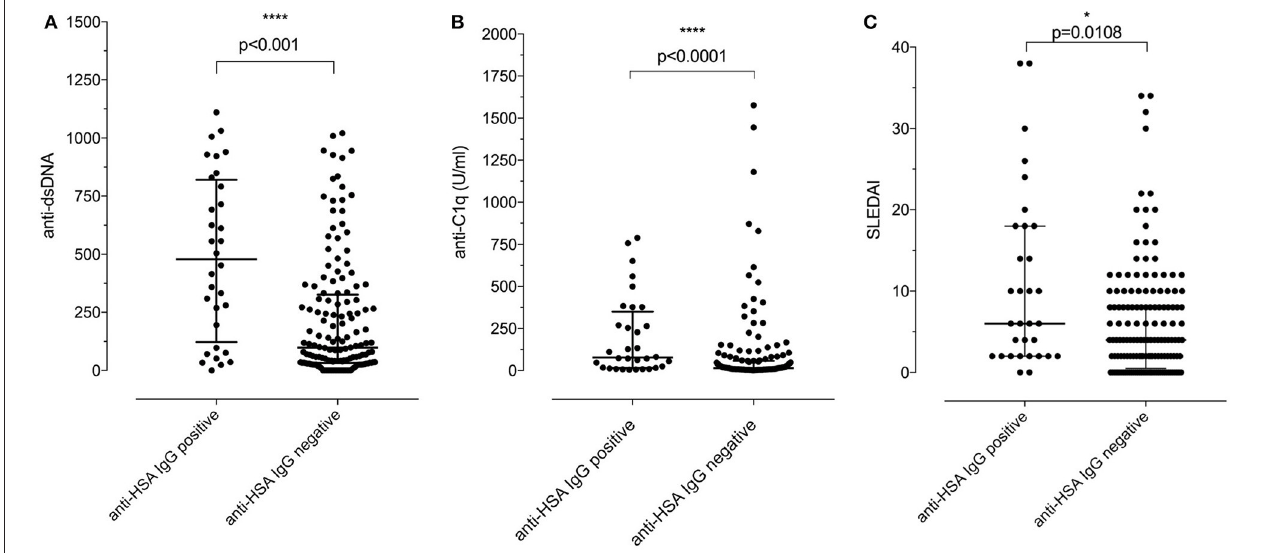
FIGURE 3 | (A) Association of positivity/negativity for anti-HSA IgG with levels of anti-dsDNA antibodies in SLE patients. Anti-HSA IgG positive patients had significantly higher levels of anti-dsDNA than anti-HSA IgG negative SLE patients [median of anti-HSA positive: 478 vs. median of anti-HSA IgG negative: 98.5; p < 0.001 (Mann–Whitney)]. (B) Association of positivity/negativity for anti-HSA IgG with levels of anti-C1q antibodies in SLE patients. Anti-HSA IgG positive patients had significantly higher levels of anti-C1q than anti-HSA IgG negative SLE patients [median of anti-HSA positive: 77.55 vs. median of anti-HSA negative: 14.9; p < 0.001 (Mann–Whitney)]. (C) Association of positivity/negativity for anti-HSA IgG with the SLEDAI in SLE patients. Anti-HSA IgG positive patients had significantly higher SLEDAI than anti-HSA IgG negative SLE patients [median of anti-HSA positive: 6 vs. median of anti-HSA negative: 4; p = 0.0108